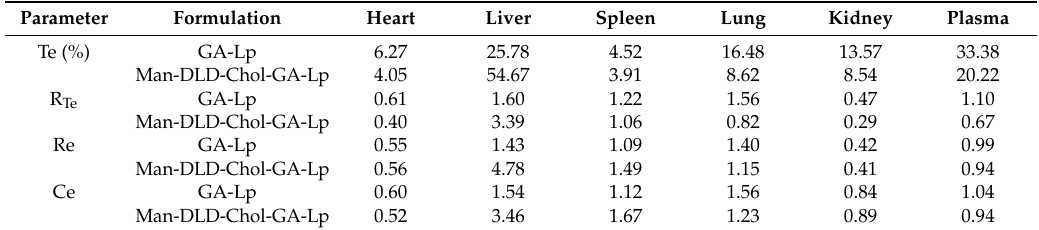
Table 7. Targeting parameters of GA-Lp, and Man-DLD-Chol-GA-Lp in mice tissues and plasma.